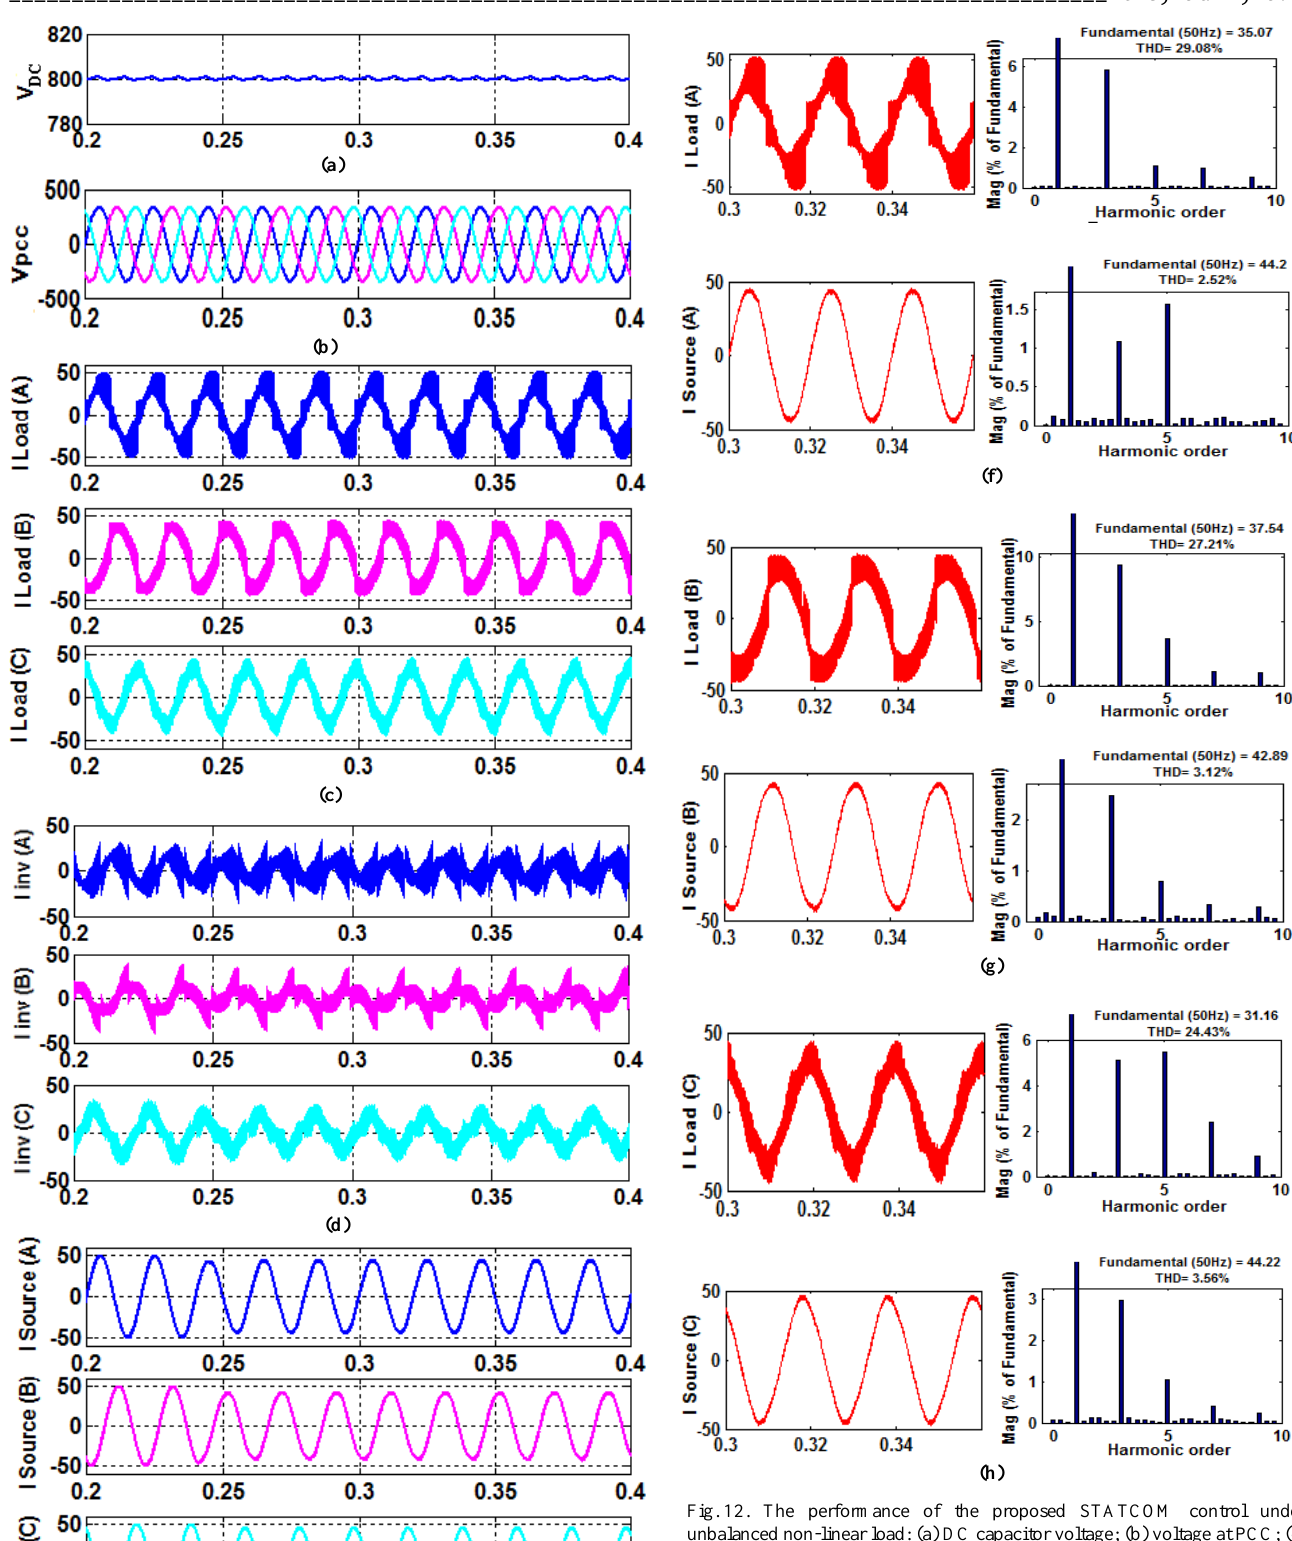
Fig. 12. The performance of the proposed STATCOM control under unbalanced non-linear load: (a) DC capacitor voltage; (b) voltage at PCC; (c) load current profiles separately for all three phases; (d) STATCOM (inverter) compensating current profiles separately for all three phases; (e) compensated source current profiles separately for all three phases. Harmonic spectra of load currents and compensated source currents for (f) phase a; (g) phase b; (h) phase